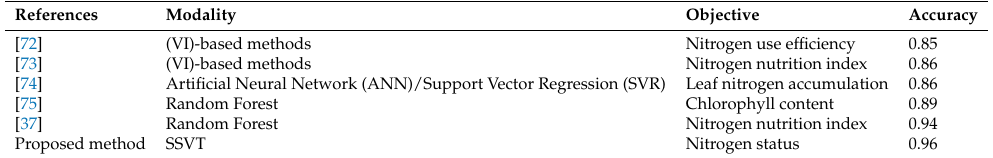
Figure 11. Visualization of the attention map for ResNet and proposed SSVT. The middle column represents the attention map of ResNet. The right column represents the attention map of SSVT. Table 8. Comparative performance of the classifier vs. five competitors on wheat Nitrogen